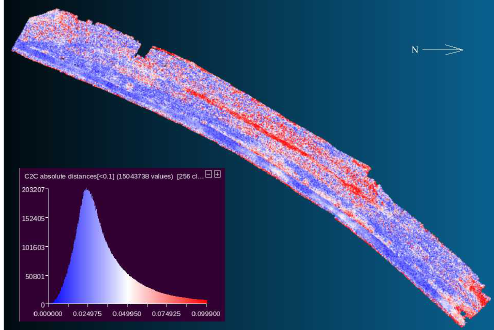
Figure 9: Comparison between the first Lidar survey and the pointcloud from the RadialBasic model